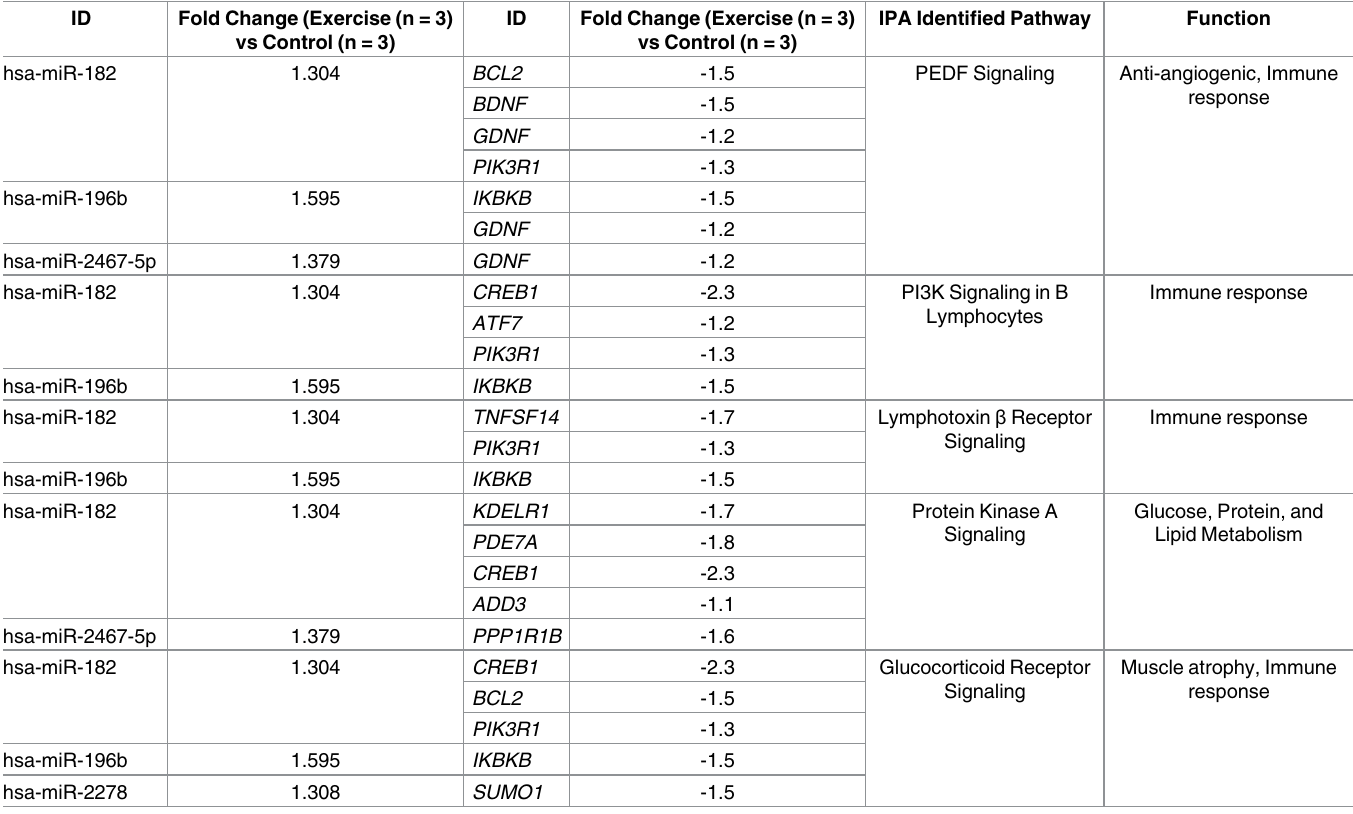
Table 3. Pathway analysis of expression-paired microRNA-mRNA alterations in